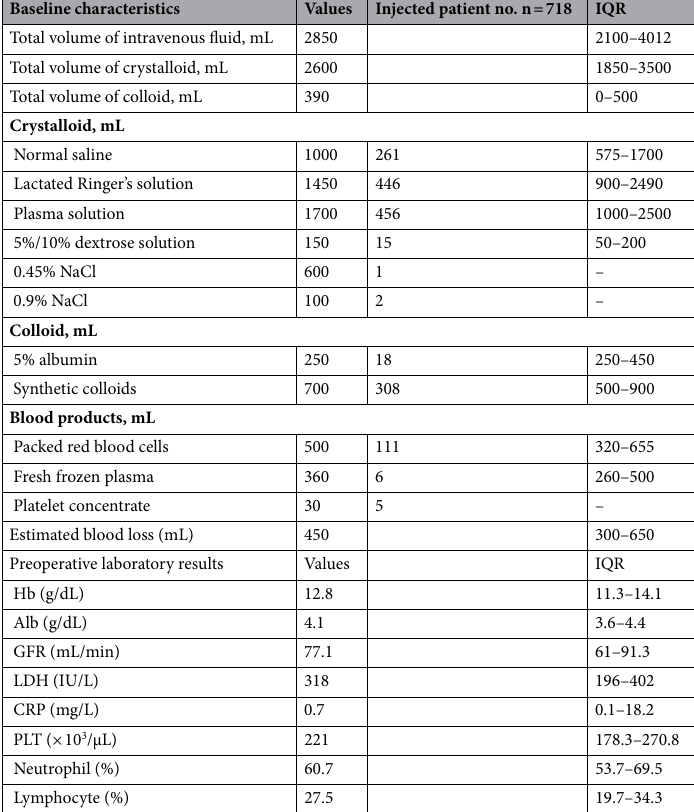
Table 2. Intraoperative intravenous fluids and primary preoperative laboratory results. Values are presented as number (%) or median. CRP C-reactive protein, GFR glomerular filtration rate, IQR interquartile range, LDH lactate dehydrogenase, PLT